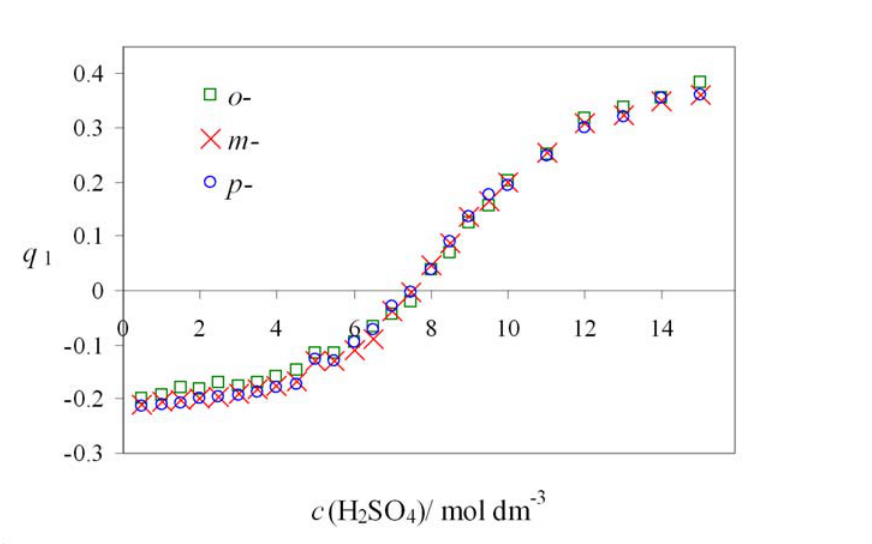
Fig. 5 Coefficients of the first principal components of benzotoluidides as a function of sulfuric acid concentration from 0.5 to 15.0 mol dm − 3